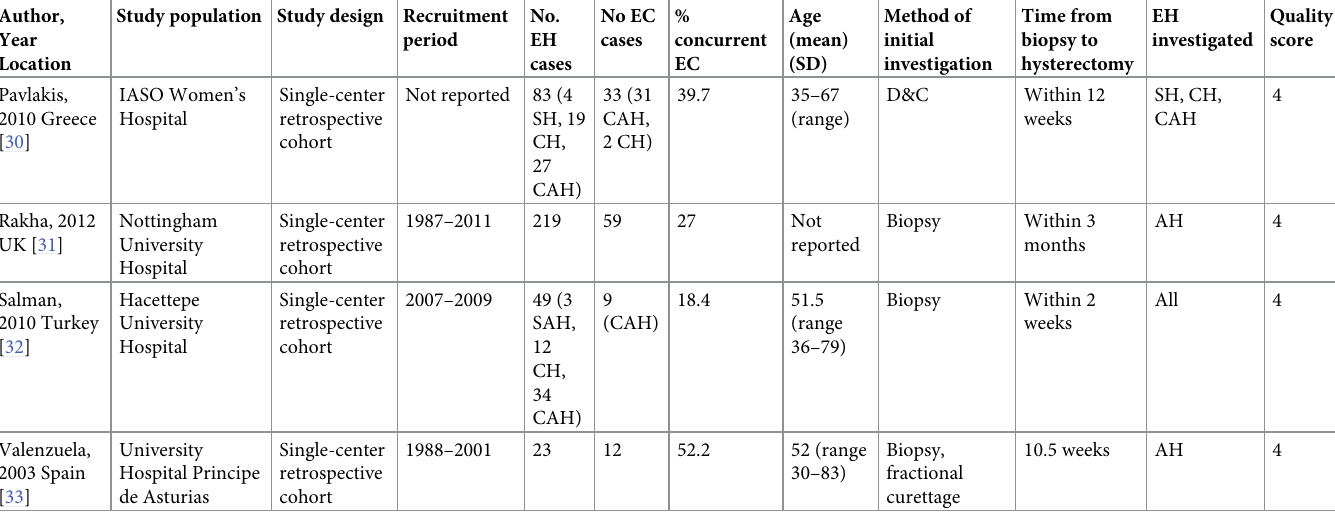
observed (I 2 = 70%), Fig 3. Only one study included only non-atypical hyperplasia patients [39] and reported a much lower rate of progression to cancer of 26.3 per 1,000 person-years (95% CI: 6.6, 105.6), or 2.6% per year. Among 4 studies (including 5 estimates), that included both atypical and non-atypical hyperplasia patients, the pooled rate of progression to cancer was 12.4 per 1,000 person-years (95% CI: 6.2, 24.9), or 1.2% per year (again incorporating high heterogeneity, I 2 = 81%), Fig 3. After pooling results from all 10 studies (including 12 esti- mates), with 1,400 women with any type of endometrial hyperplasia, the incidence rate